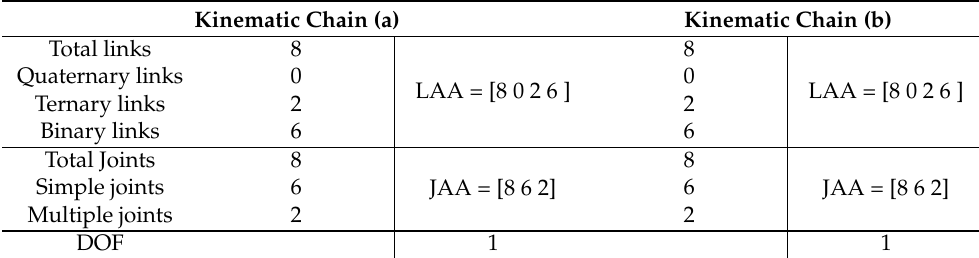
Figure 11. Two 8-link kinematic chains with simple and multiple joints. ( a ) kinematic chain: a. ( b ) kinematic chain: b. The link assortment array (LAA) and joint assortment array (JAA) for the KCs shown